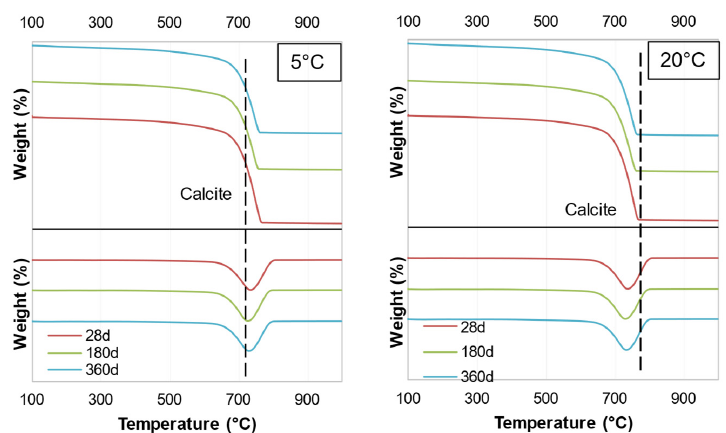
Figure A7. TGA results of S + C + W1.